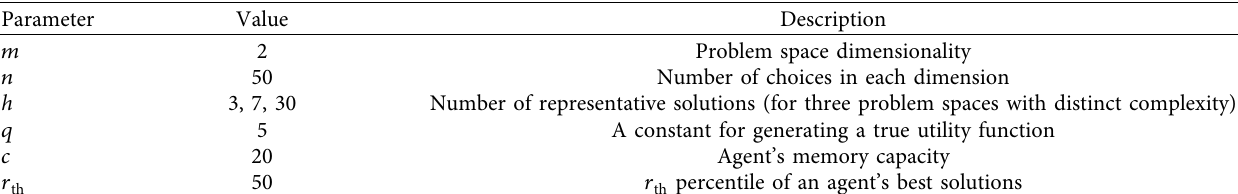
Table 3: Model parameter settings in the simulation experiments.